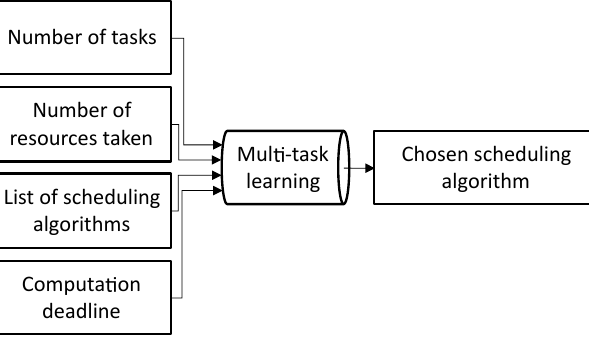
Figure 2. Overview of the task scheduling